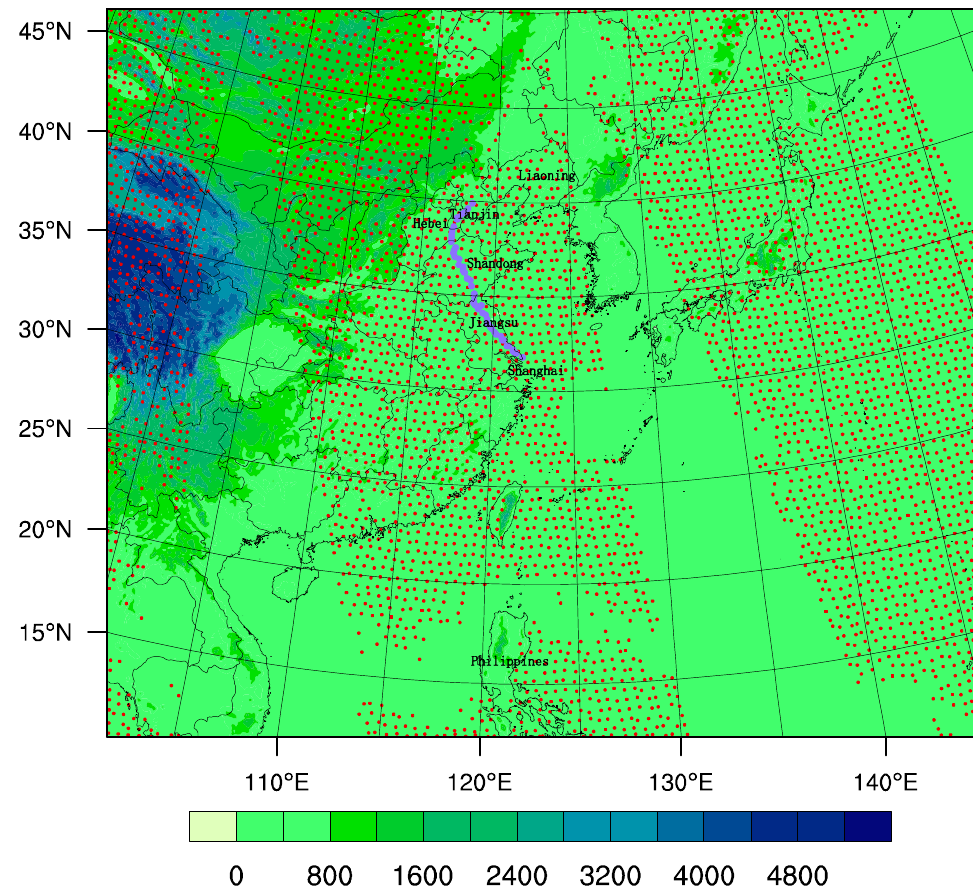
Figure 1. The track of tropical storm Ampil (violet dot line) covered by the scanning orbits (red dots) in the model domain overlapped by terrain height (filled colors, unit: m).